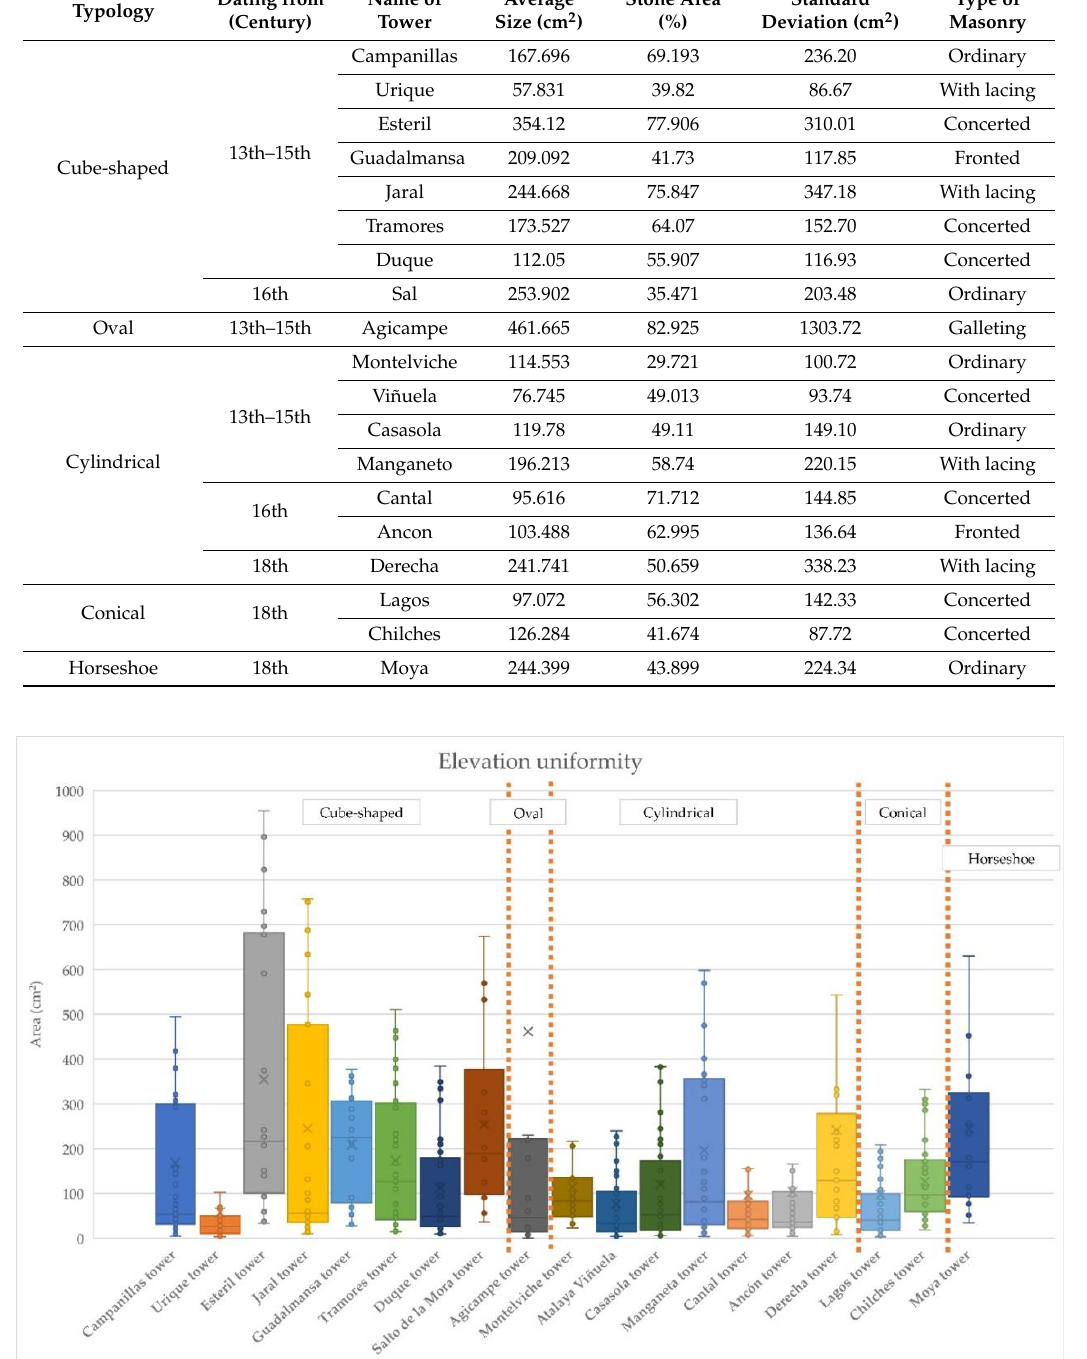
Figure 14. Analysis of masonry homogeneity .